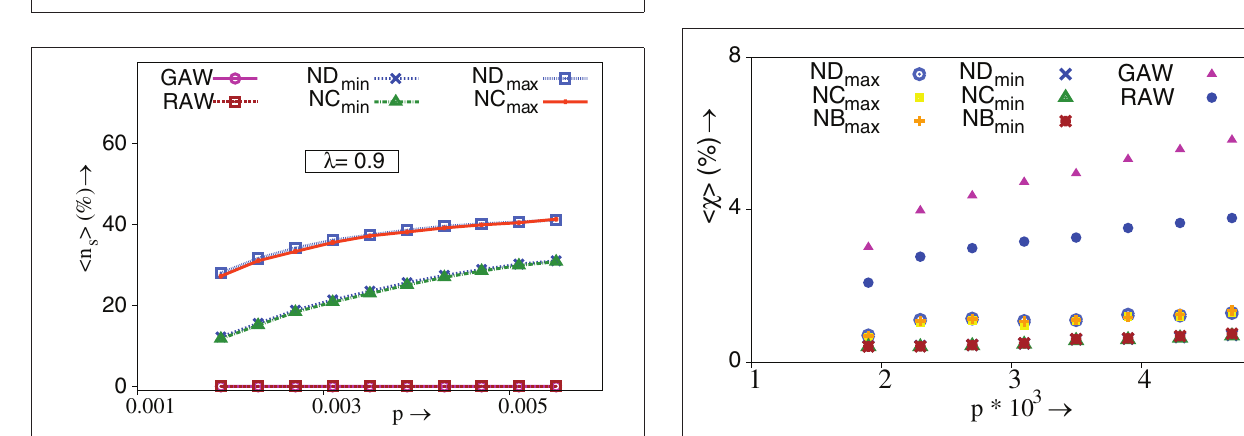
FIGURE 3 | Degree distribution profiles for different types of genotypes in a landscape: local optimum, non local optimum and valleys for p = 0.0021 and p ∗ = 0.0053. Observed results are for N = 1024, N E = 10 5 . The topology of the genotype space is based upon Erdös Rényi graphs. The fitness values are drawn from a bivariate Gaussian distribution with correlation parameter, λ = 0.9. All other conditions are as in Figure 2F .